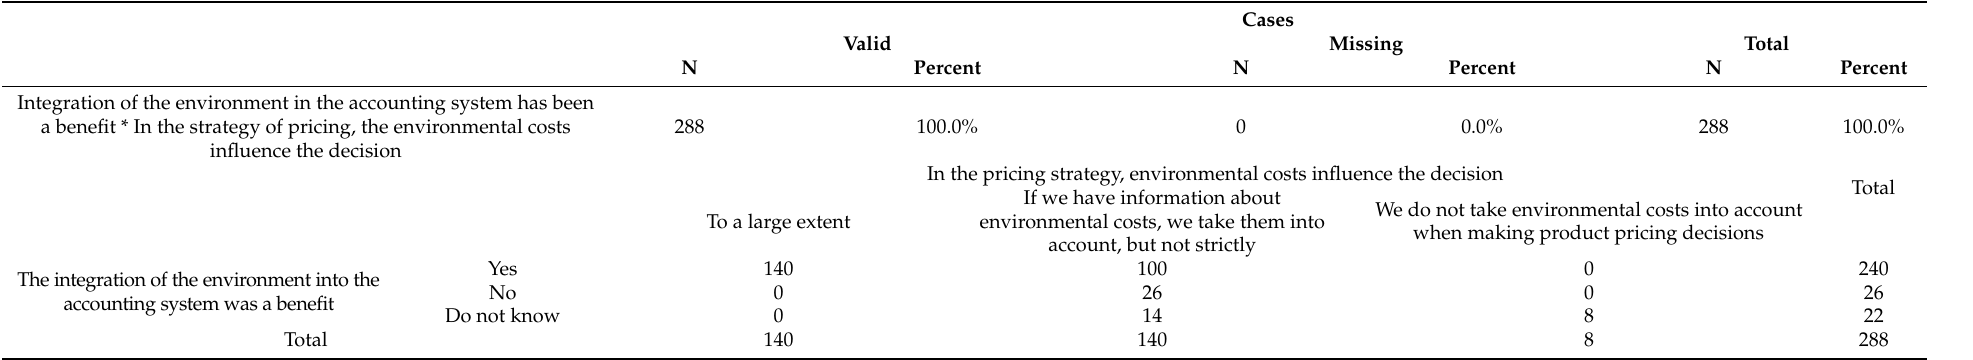
Table 13. The result of the cross-analysis of the variables Benefits of integrating the environment in the accounting system * Decision of integrating the environmental costs in the prices of the